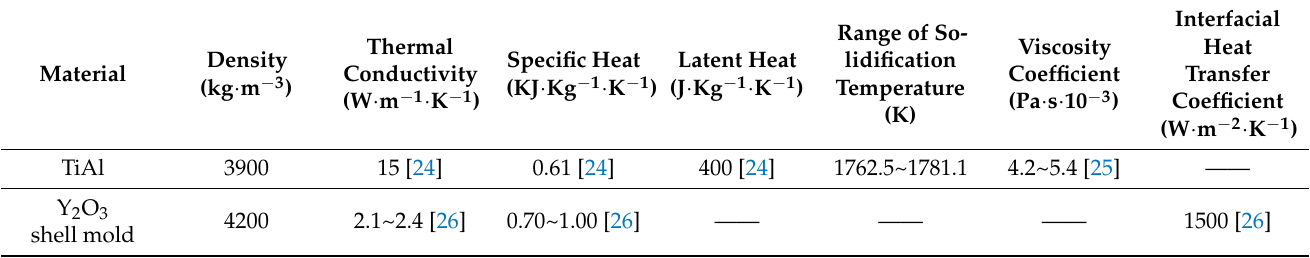
Figure 2. Gating system ( a ) integrated gating system, ( b ) bottom 4× runner, and ( c ) bottom 8× runner. In ( a ), the plan view, the case is in brown and the gating system is in green. ( b , c ) show the bottom view. In ( b ), the metal liquid flows from the 4× cross runner into the case. In ( c ), the metal liquid flows from the 4× cross runner into the case. Table 1. The main thermal and physical properties of TiAl alloy and ceramic shell mold for simulation [24–27].